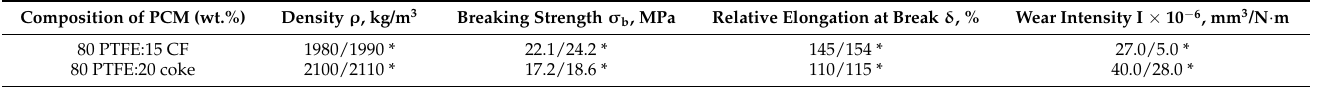
Table 4. Properties of composites based on activated PTFE and